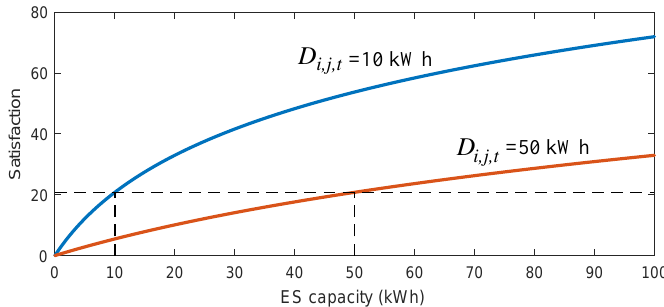
Figure 3. Examples of satisfaction functions with D i , j , t = 10 kWh and D i , j , t = 50